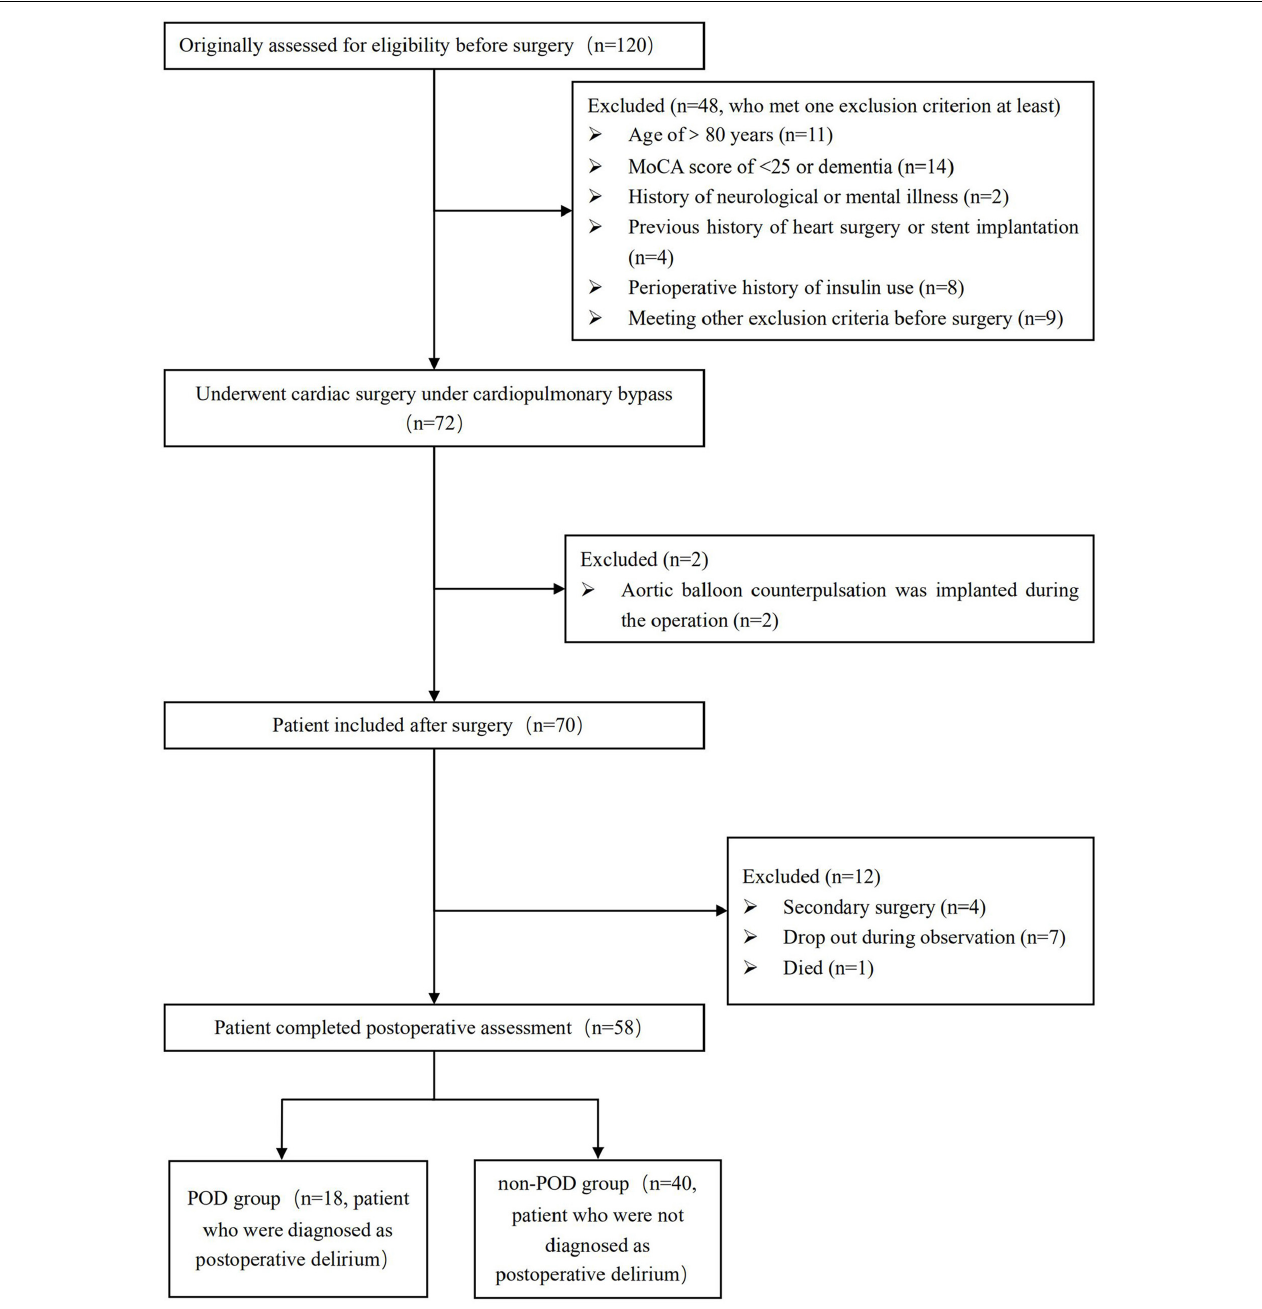
FIGURE 1 | Flowchart showed the patient selection process in our matched case-control study.